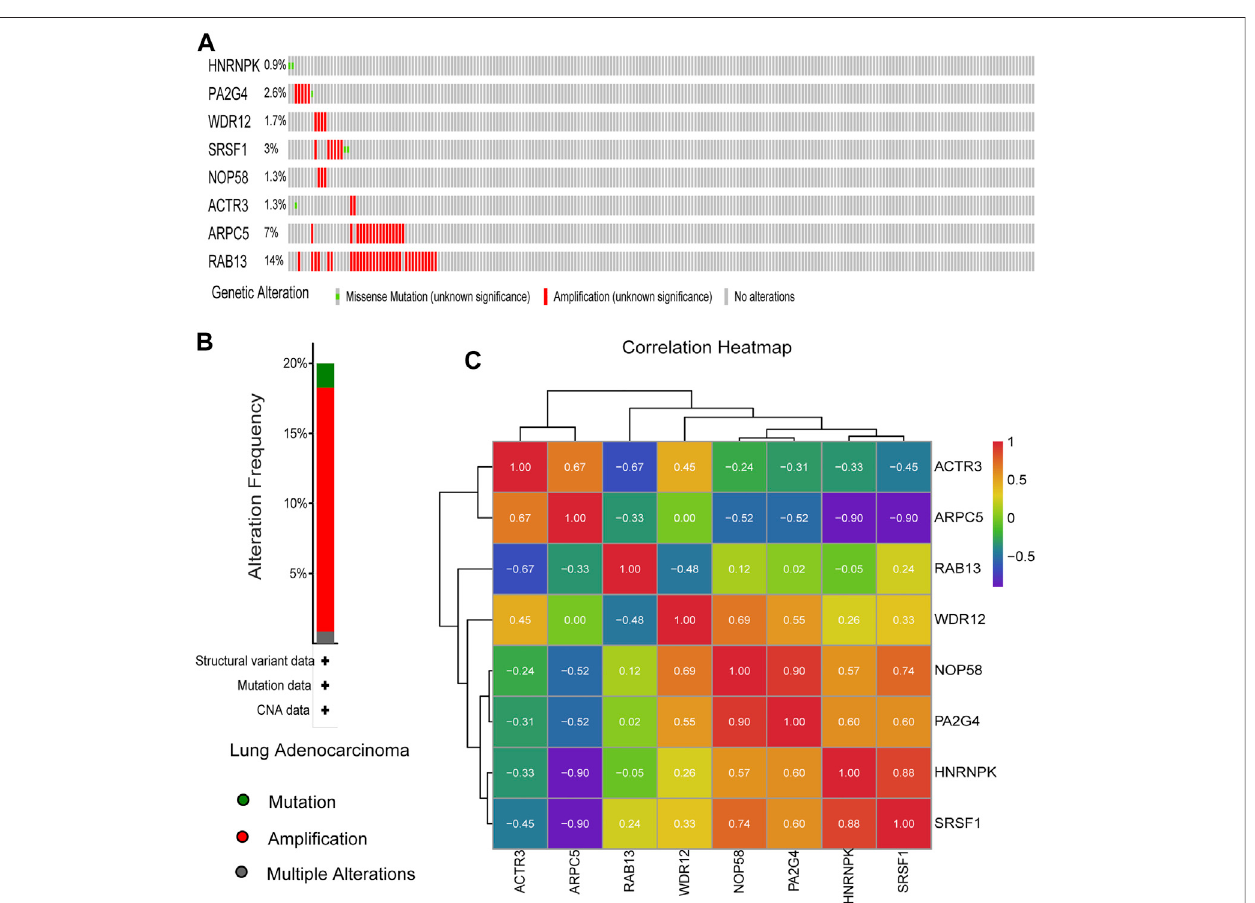
FIGURE 9 | Genetic alteration information and co-expression analysis of the eight hub genes. (A) A visual summary across a set of lung adenocarcinoma (LUAD) (data from Lung Adenocarcinoma, The Cancer Genome Atlas (TCGA), Nature 2014) showed the genetic alterations connected with the eight hub genes, which were alteredin75(31.8%)of230sequencedpatients(230intotal). (B) AnoverviewofchangesintheeighthubgenesfromthegenomicsdatasetsofLUADinTCGAdatabase. Summary for lung adenocarcinoma: Gene altered in 20% of 230 cases, Mutation 1.74% (4 in 230 cases), Ampli fi cation 17.39% (40 in 230 cases), and Multiple Alterations 0.87% (2 in 230 cases). (C) The co-expression analysis of the eight hub genes using the 230 samples above based on cBioPortal database.